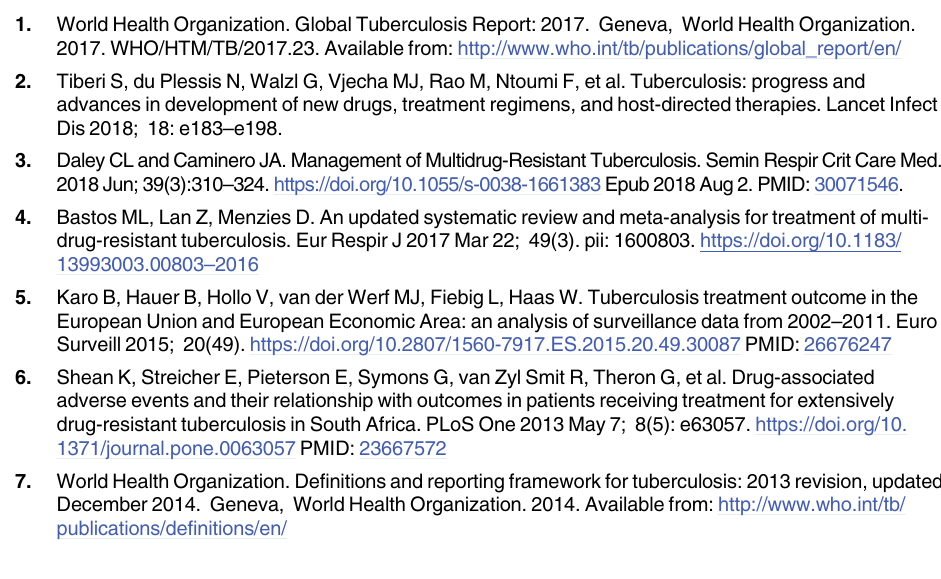
S2 Table. Correlation between outcome and social constraints. S3 Table. Correlation between outcome and